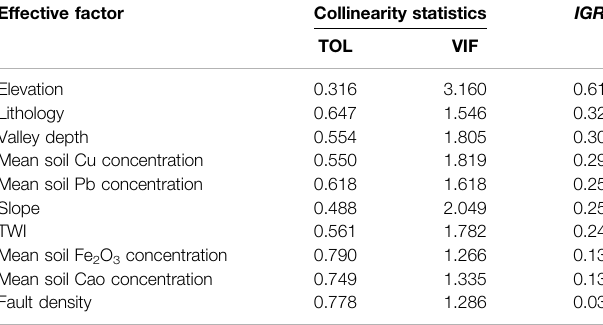
TABLE 2 | Multicollinearity analysis using VIF, TOL, and IGR. Effective factor Collinearity